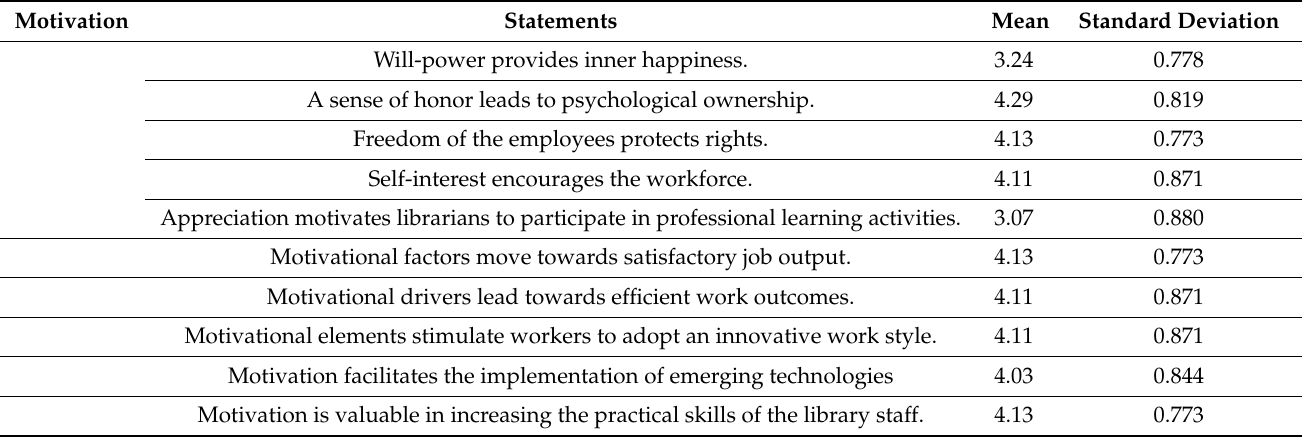
Table 2. Descriptive analysis of respondents’ opinions about different statements related to the study’s key variables (N =